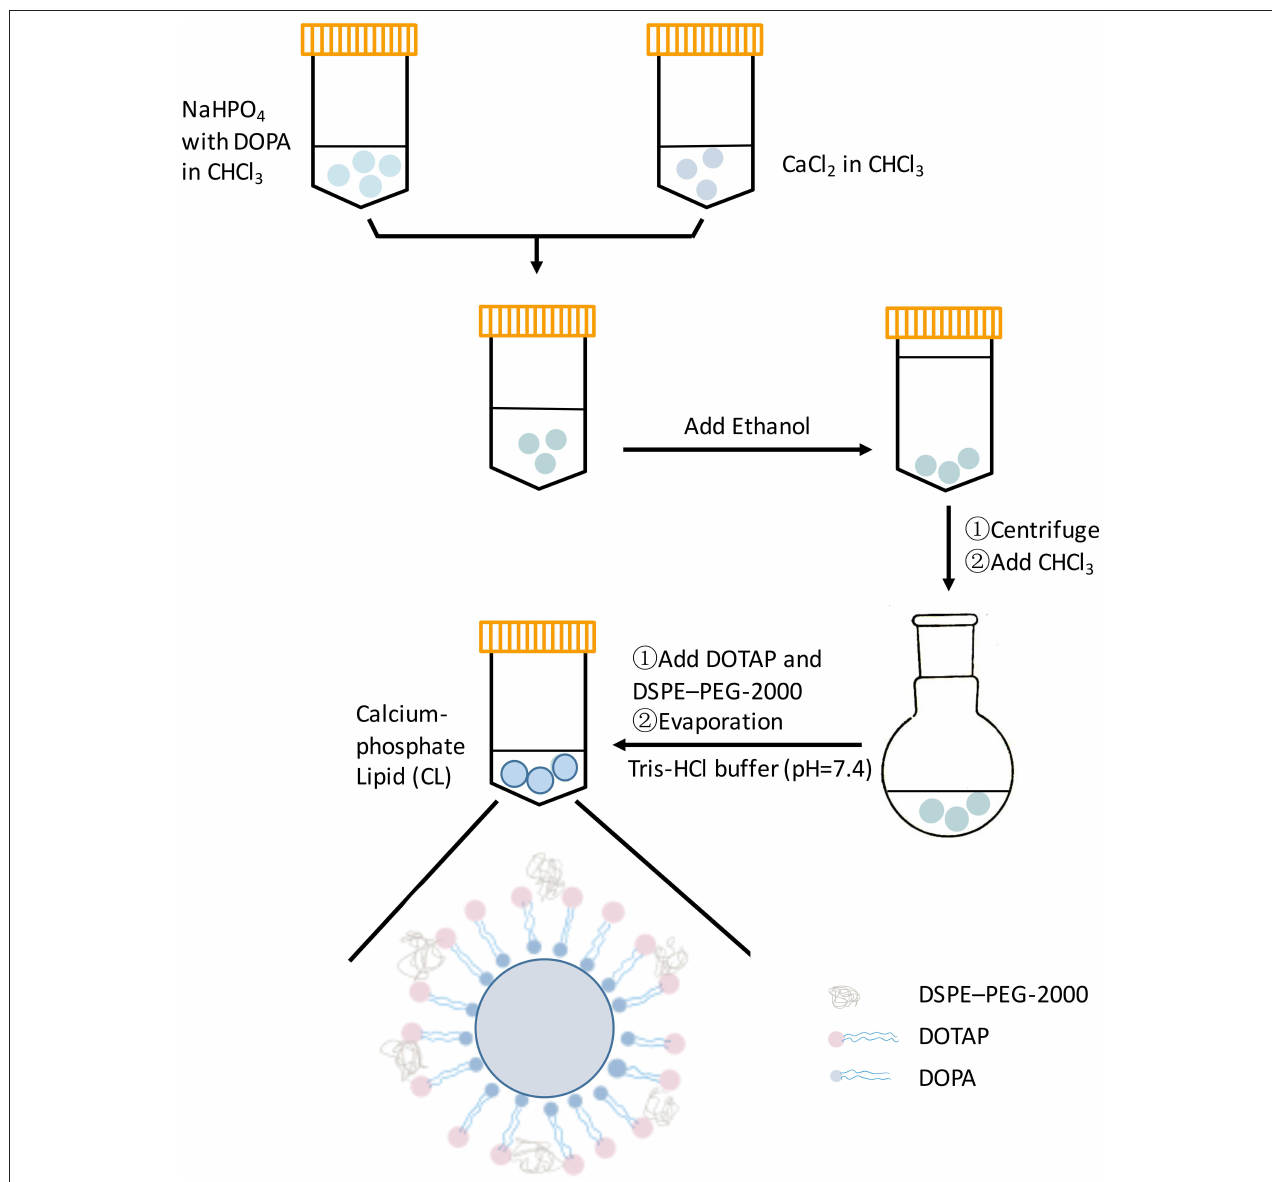
FIGURE 1 | Schematic representation of proposed method to synthesis